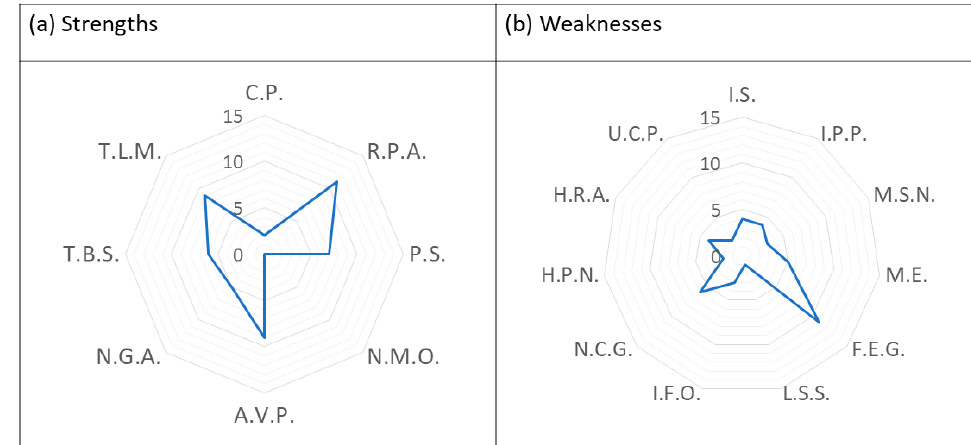
Figure 6. Total number of responses for each category related to the strengths and weaknesses of Fire Flocks. Each respondent was asked to select a maximum of three. ( a ) Strengths: Communicative power (C.P.); Raise Public Awareness (R.P.A.); Prestige for the sector (P.S.); New marketing oppor- tunities (N.M.O.); Adding value to the products (A.V.P.); New grazing areas (N.G.A.); Technical and bureaucratic support (T.B.S.); Transforming landscapes and managing wildfire risk (T.L.M.). ( b ) Weaknesses: Increase sales (I.S.); Increase the price of products (I.P.P.); More farmers in the net- work (M.S.N); More establishments (M.E.); Fair economic return for the grazing service (F.E.G.); Lack of stable technical management and communication staff (L.S.S); Inaccessible forest owners (I.F.O); Need to combine grazing with mechanical treatments (N.C.G); High presence of non-palatable plants (H.P.N); High restriction of eligible areas according to CFRS (H.R.A); Uncertain conti- nuity of the project due to funding issues (U.C.P).